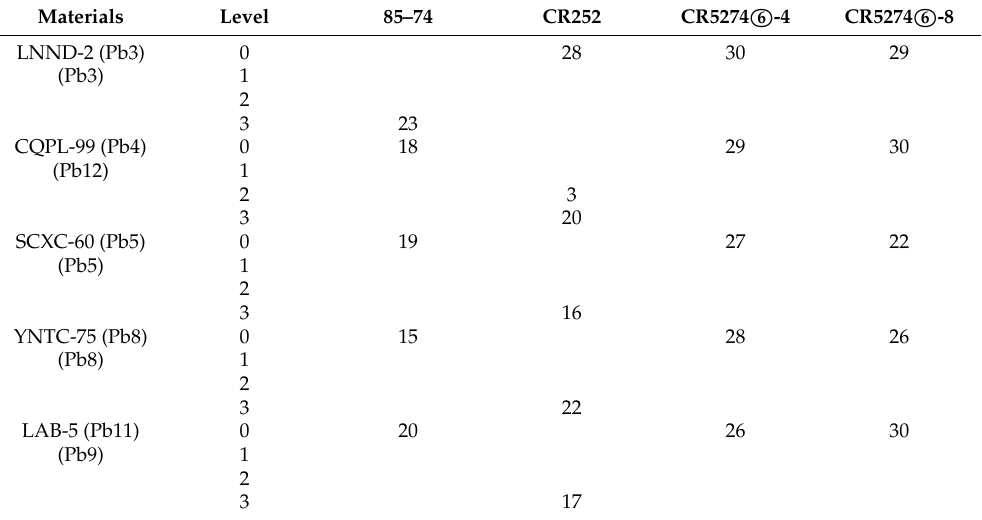
Table 5. Resistance identification of gene-pyramided lines inoculated with different P. brassicae